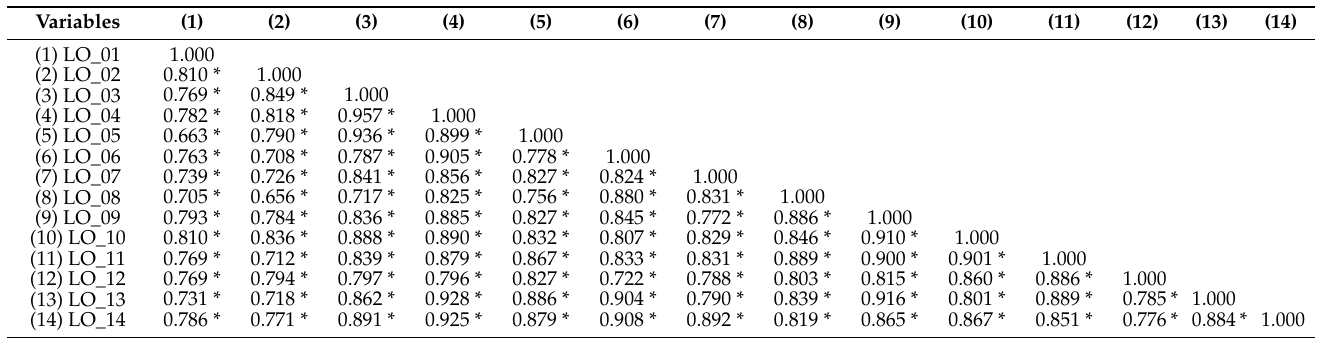
Table 12. Pearson correlations by learning outcomes’